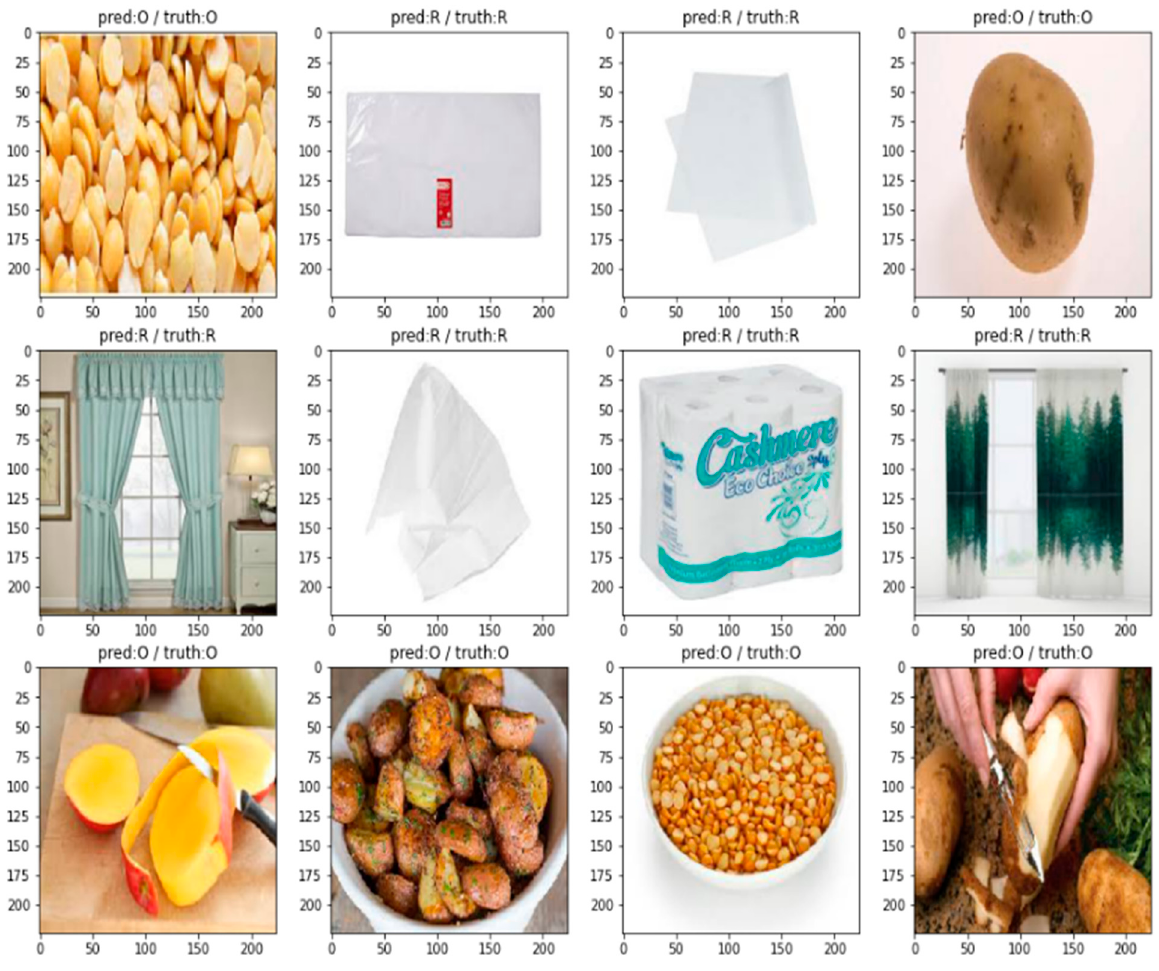
Figure 9. Prediction in addition to classification.